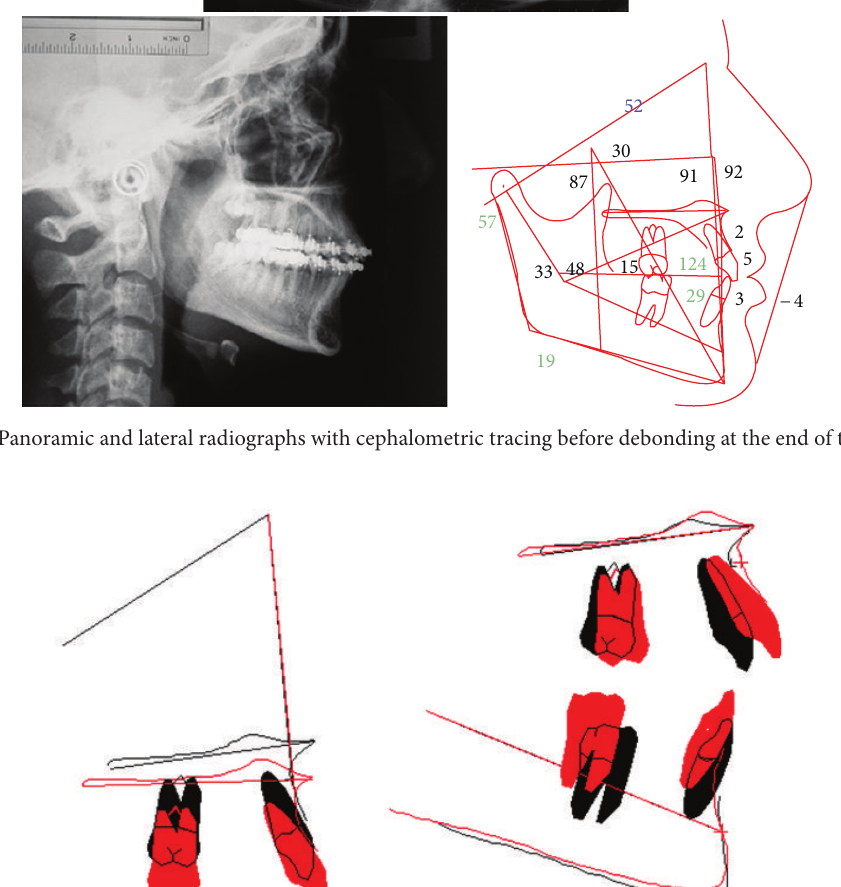
(iv) .018 󸀠󸀠 × .025 󸀠󸀠 HA Ni-TI upper and lower archwires (3M Unitek, Monrovia, CA,USA); (v) .019 󸀠󸀠 × .025 󸀠󸀠 SS upper and lower archwires (3M Unitek, Monrovia, CA,USA); (vi) .018 󸀠󸀠 × .025 󸀠󸀠 multibraded wires with vertical elastics (1/8 󸀠󸀠 , 4 Oz) for improving